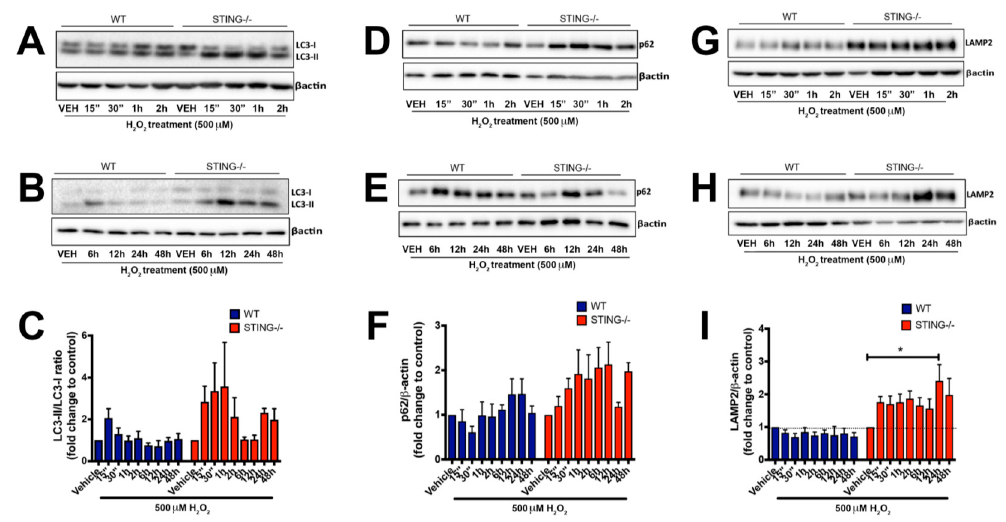
Figure 6. STING − / − cells display increased accumulation of autophagy markers following H 2 O 2 treatment. WT and STING − / − cells were treated with 500 µ M H 2 O 2 for 15 min to 2 h ( A , D , G ) and 6 h to 24 h ( B , E , H ), and LC3, p62 and LAMP2 protein expression was analyzed by Western blot analysis (representative blot of n = 4 blots). LC3-I, LC3-II, p62 and LAMP2 levels were normalized to β -actin levels ( C , F , I ). For densitometry calculations, the LC3-II / LC3-I ratio was then determined from these values and was calculated as a fold change relative to the vehicle control as shown in ( C ). Data are expressed as mean ± SEM. (“) = min. * p < 0.05.